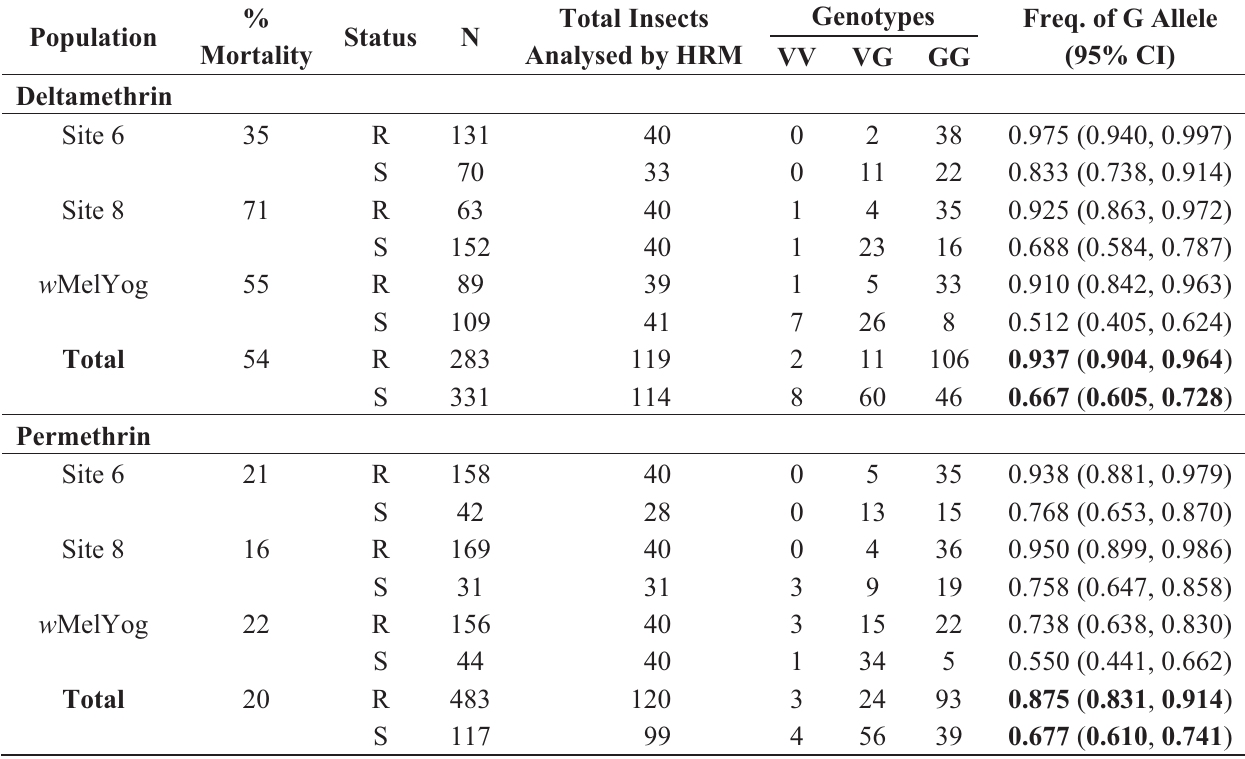
Table 6. Genotypes and allele frequencies of Vssc mutation V1023G in Aedes aegypti mosquito samples of Yogyakarta assayed with deltamethrin and permethrin. Population